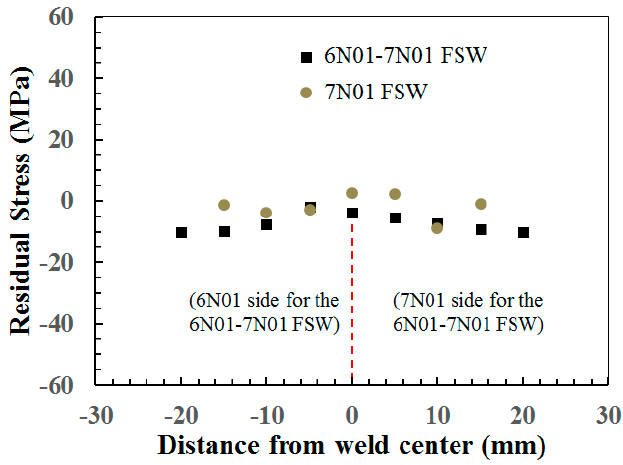
Figure 8. Residual stress distribution for the 7N01 FSW and the 6N01-7N01 FSW.